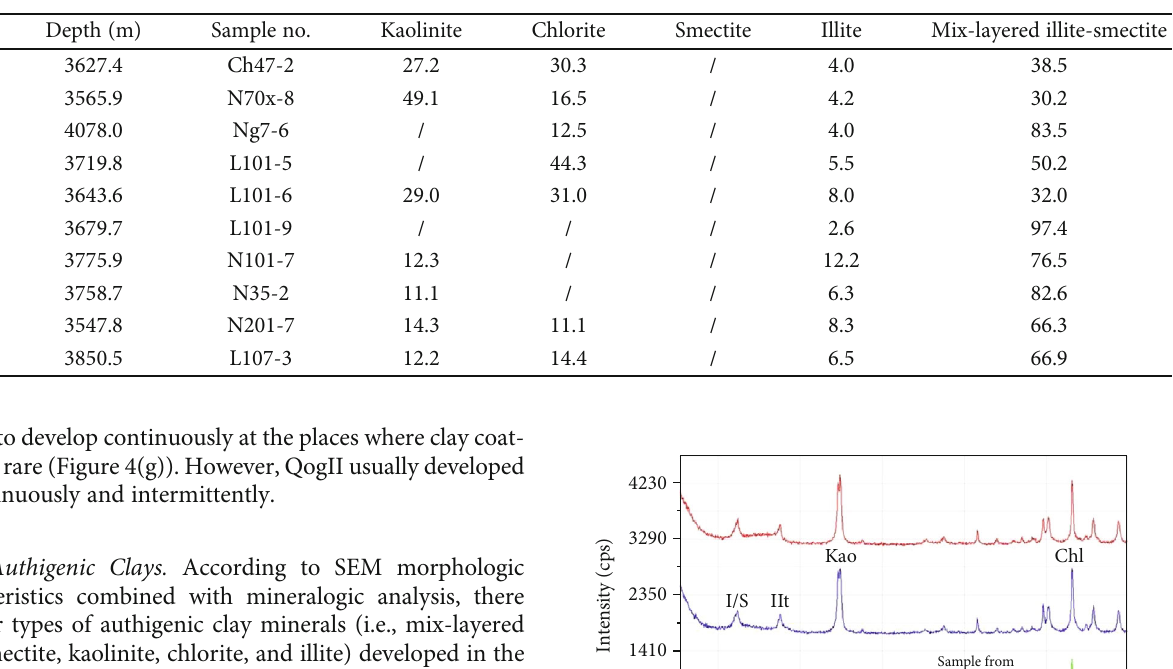
sandstones. 3 member